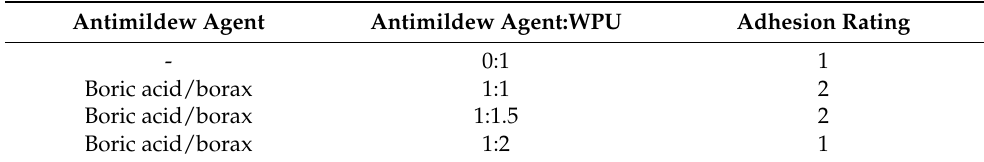
Table 3. Adhesion grades of the coatings with different ratios between boric acid/borax and WPU.